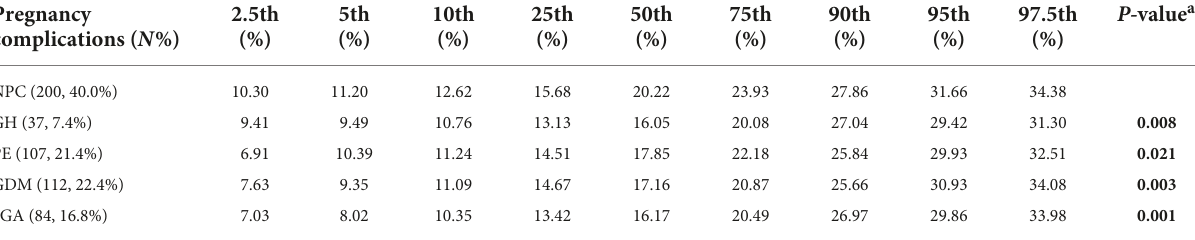
TABLE 2 The different percentiles of FF on NIPT based on pregnancy